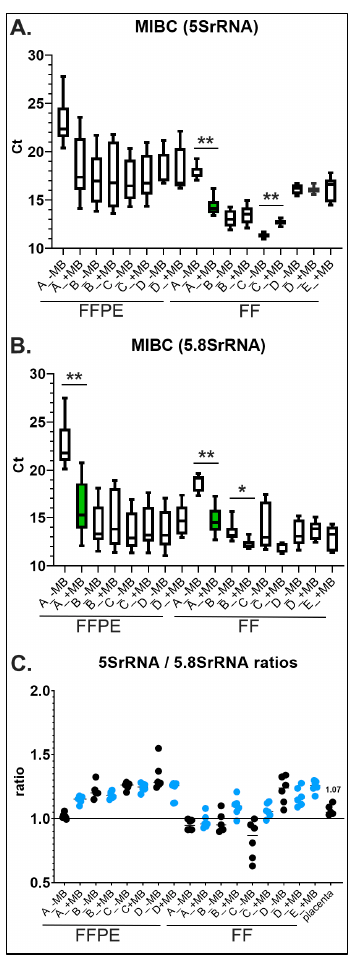
Figure 3. MIBC qPCR 5SrRNA and 5.8SrRNA values from RNA isolated from FFPE and FF tissues using different isolation methods. ( A ) Each box graph shows 5SrRNA Ct values ( Y -axis) from RNA isolated from six different FFPE MIBC tissues and patient matched FF MIBC tissues with (+) or without ( − ) MB prior staining using four different isolation methods (A–D) (Table 1); ** p = 0.0022, n = 6 technical replicates. ( B ) Each box graph shows 5.8SrRNA Ct values ( Y -axis) from RNA isolated from six different FFPE MIBC tissues and patient matched FF MIBC tissues with (+) or without ( − ) MB prior staining using four different isolation methods for FFPE (A–D) and five isolation methods for FF (Table 1); ** p = 0.0043; * p = 0.026, n = 6 technical replicates. ( C ) Graph shows ratios ( Y -axis) of 5SrRNA / 5.8SrRNA Ct values from RNA isolated from six different FFPE MIBC tissues and patient matched FF MIBC tissues with (+) or without ( − ) MB prior staining using four different isolation methods for FFPE (A–D) and five isolation methods for FF tissues (Table 1). Far right represents control human placenta ( n = 5) (flash frozen tissue in liquid nitrogen and isolated with Method E) used for